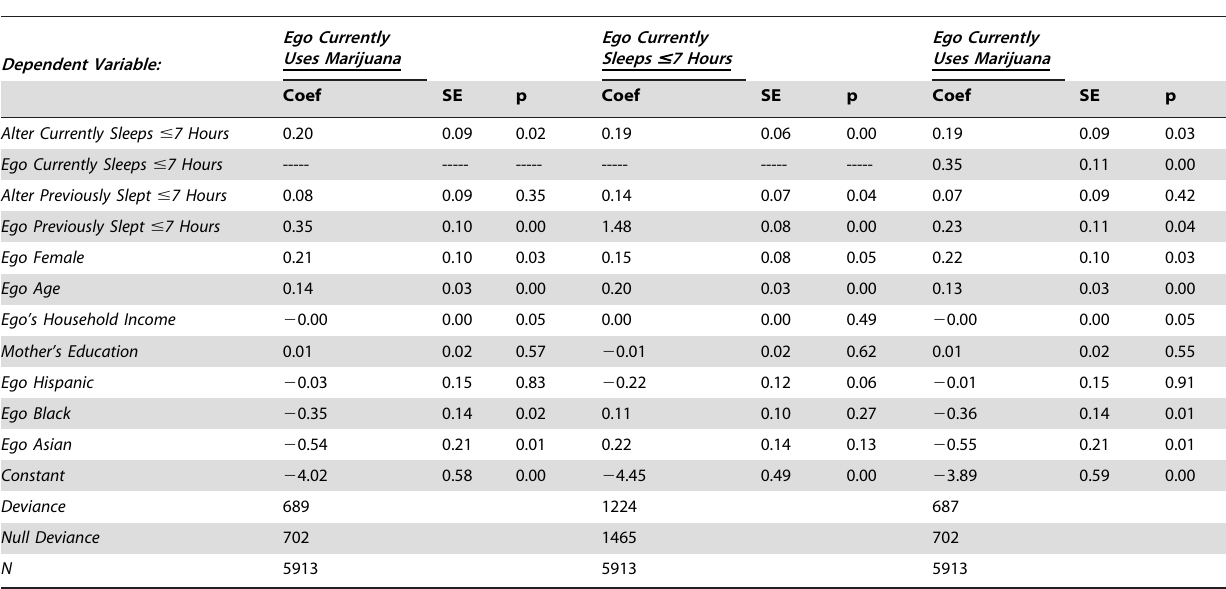
Table 3 shows mediation effect of sleep on drug use. First three columns show logistic regression model of ego’s marijuana use behavior (the outcome variable) on alter’s sleep behavior (the explanatory variable). Second three columns show logistic regression model of ego’s sleep behavior (the mediator variable) on alter’s sleep behavior (the explanatory variable). Last three columns show logistic regression model of ego’s marijuana use behavior (the outcome variable) on ego’s sleep behavior (the mediator variable) controlling for alter’s sleep behavior (the explanatory variable). Models were estimated using a general estimating equation with clustering on the ego and an independent working covariance structure. Models with an exchangeable correlation structure yielded poorer fit. Fit statistics show sum of squared deviance between predicted and observed values for the model and a null model with no covariates. A bootstrap procedure that takes into account uncertainty of both the effect of the independent variable on the mediator and the mediator on the outcome variable shows that when an alter starts sleeping # 7 hours, it increases the likelihood of ego drug use by 4% (95% C.I. 1% to 7%) via its effect on the mediator (ego sleep), which represents approximately 20% of the total effect of alter sleep on ego drug use.